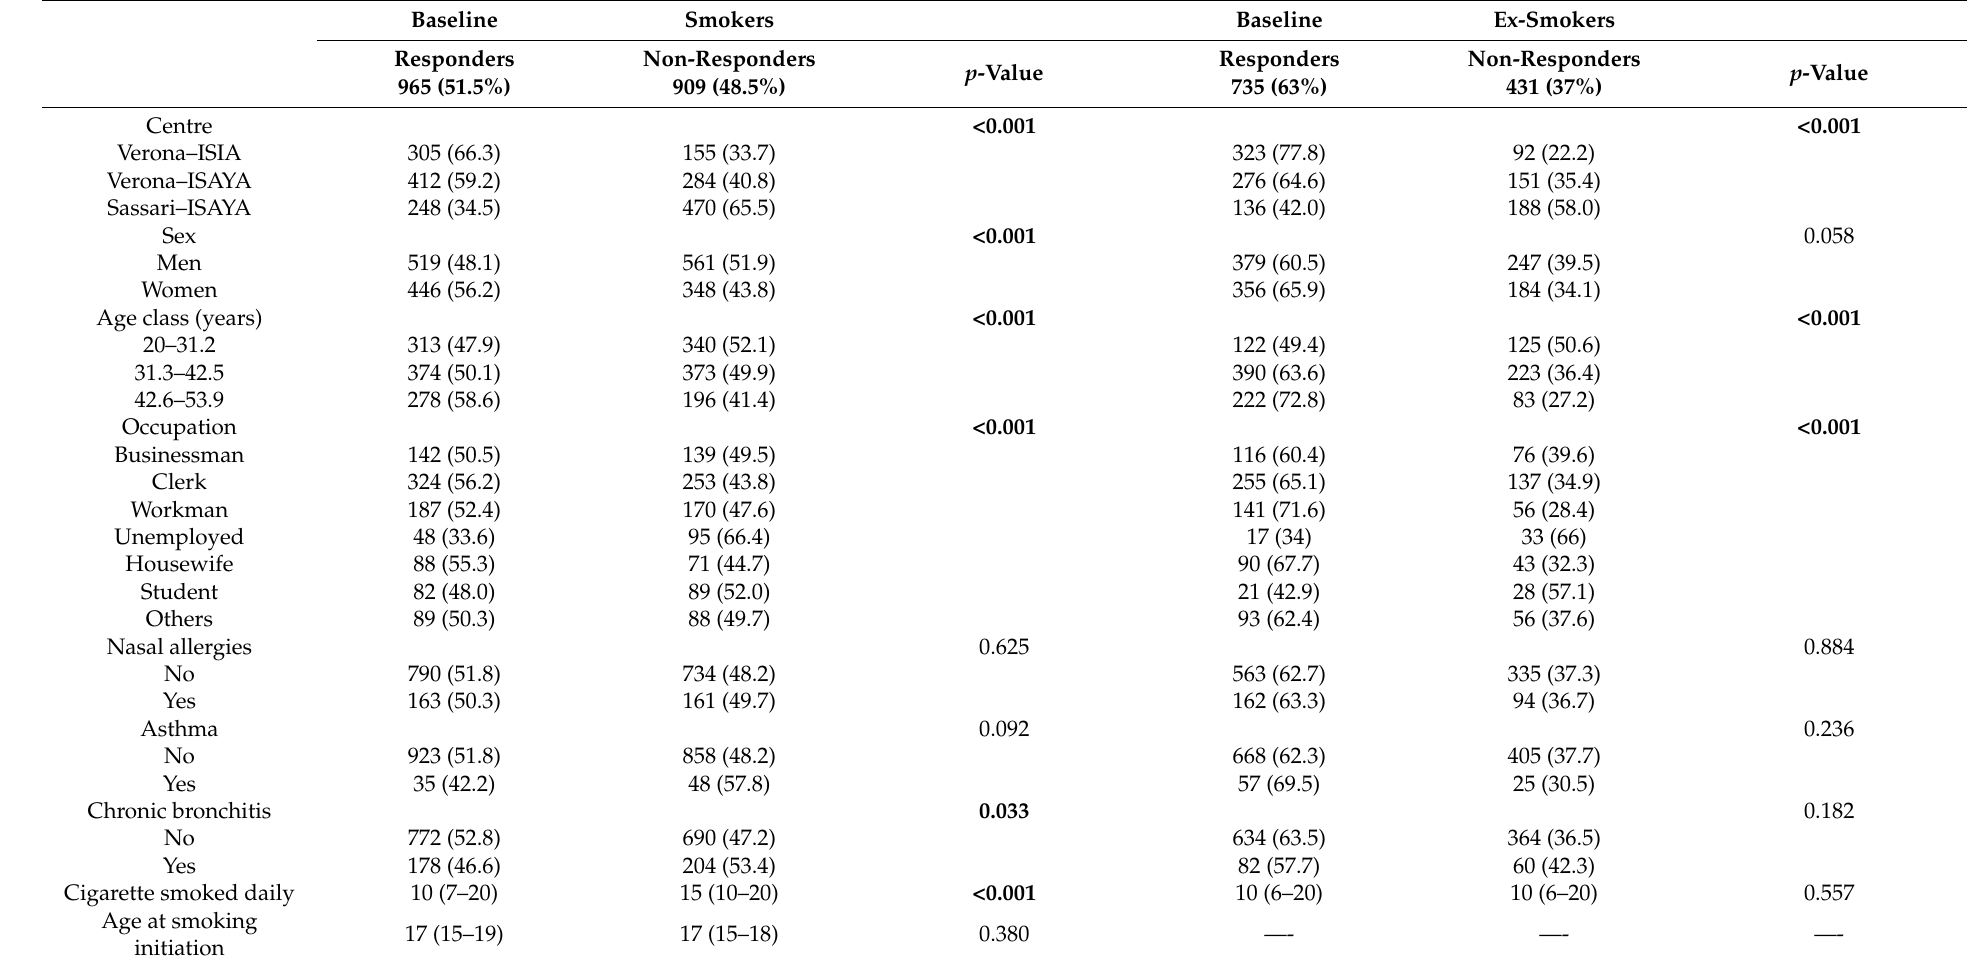
Table 1. Characteristics of responders and non-responders to the follow-up among current smokers and ex-smokers at the